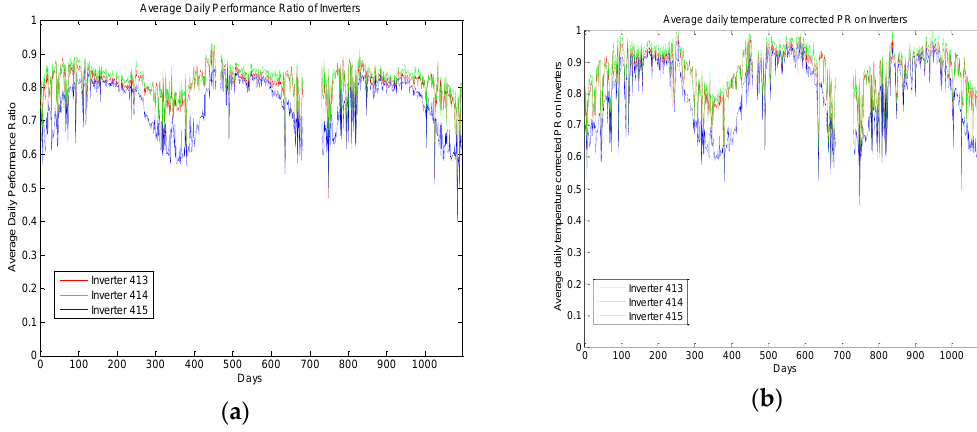
Figure 10. ( a ) Average daily performance ratio; and ( b ) average daily corrected temperature performance ratio of the production of the three inverters, from 1 January 2011 to 31 December 2013